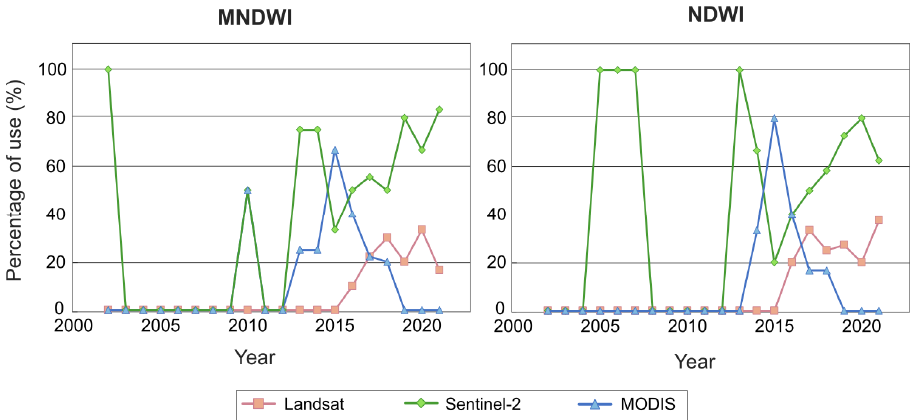
Figure 2. Percentages of applications of the Modified Normalized Difference Water Index (MNDWI, left panel) and Normalized Difference Water Index (NDWI, right panel) from 2002 to 2021 using Landsat (pink line), Sentinel-2 (green line), and MODIS (blue line) data.